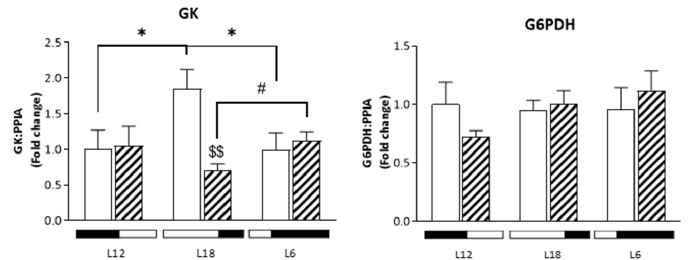
Figure 4. mRNA expression levels of liver lipid and glucose metabolism of Fischer 344 rats treated with VH or GSPE exposed to standard (12 h light:12 h dark), long (18 h light:6 h dark) or short (6 h light:18 h dark) photoperiods fed with STD diet ( n = 8). The results are presented as the mean ± SEM. * indicates significant differences within VH groups (Student’s t test, * p < 0.05); # indicates significant differences within GSPE groups (Student’s t test, # p < 0.05, ### p < 0.001); $ indicates significant differences between treatments (VH vs. GSPE) (Student’s t test, $ p < 0.05, $$ p < 0.01).